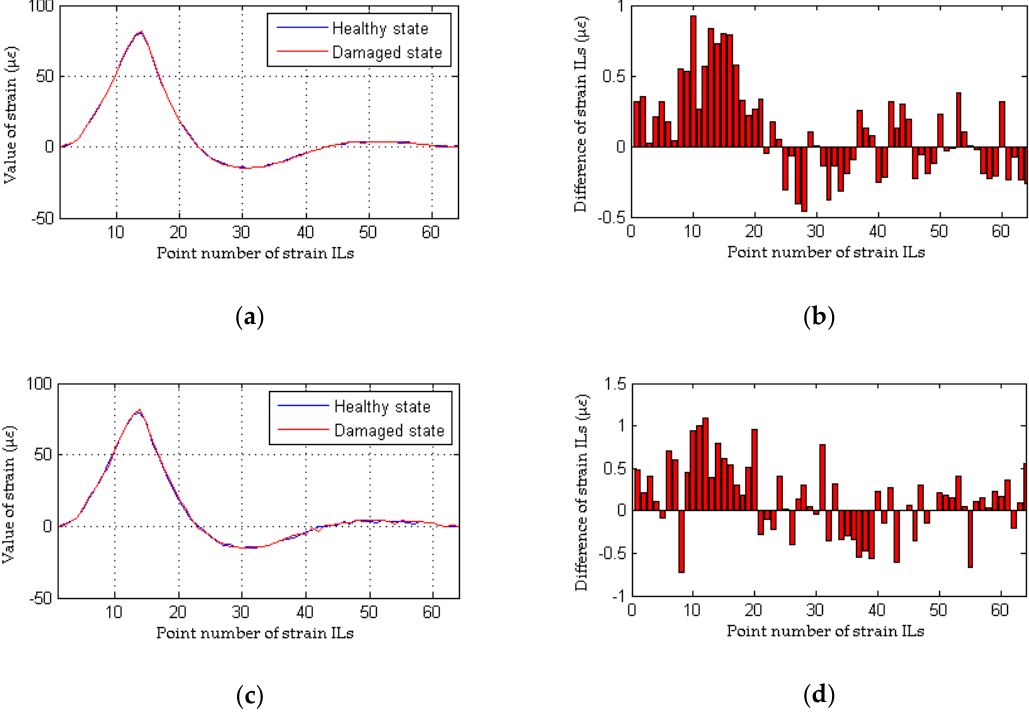
Figure 8. Results of the traditional method considering the effects of measurement noise (for a single damaged elements): ( a ) strain ILs at point #11 for case 1 and case 3; ( b ) difference in the strain ILs at point #11 before and after damage for case 3; ( c ) strain ILs at point #11 for case 1 and case 4; ( d ) difference in the strain ILs at point #11 before and after damage for case 4.